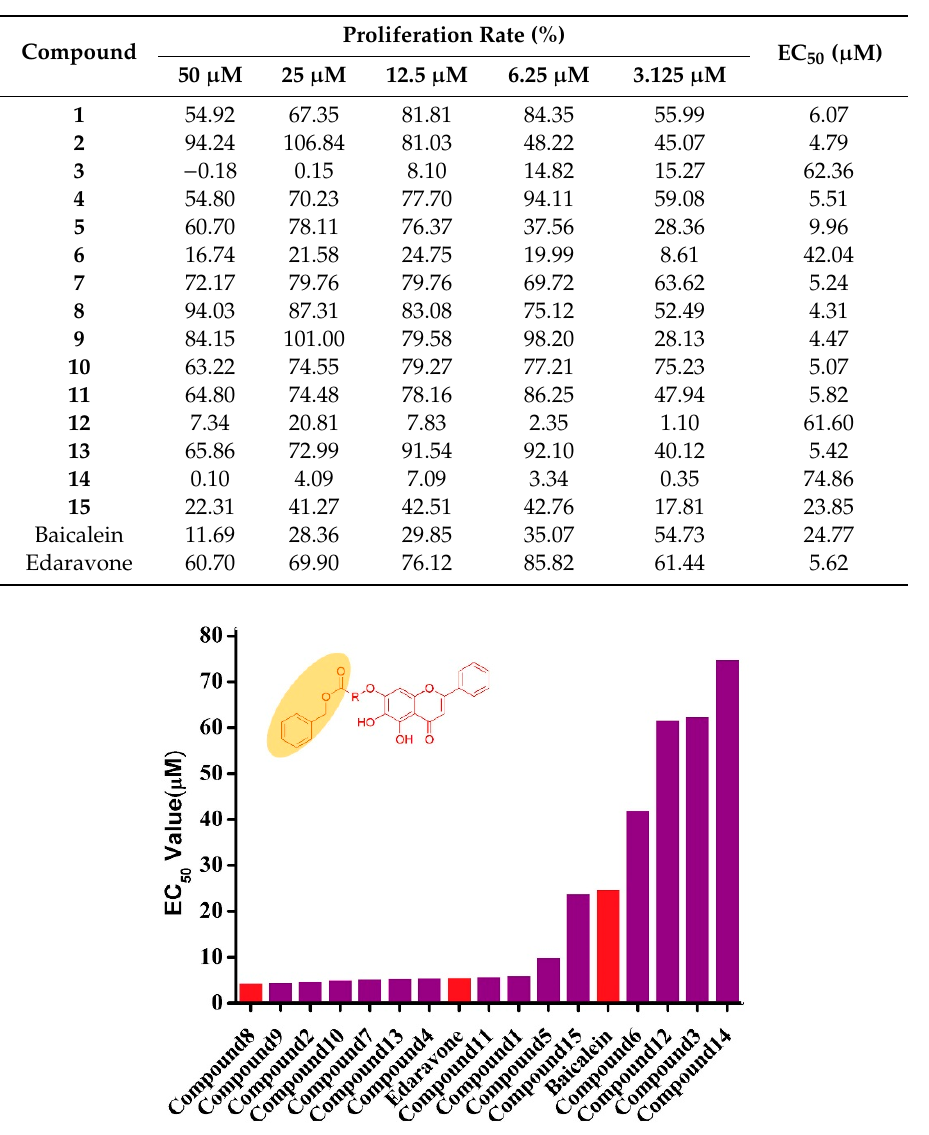
Figure 1. Structure–activity relationships of baicalein derivatives. The results show that cbz-protected baicalein amino acid derivatives show better neuroprotective activity than the boc-protected baicalein amino acid derivatives.